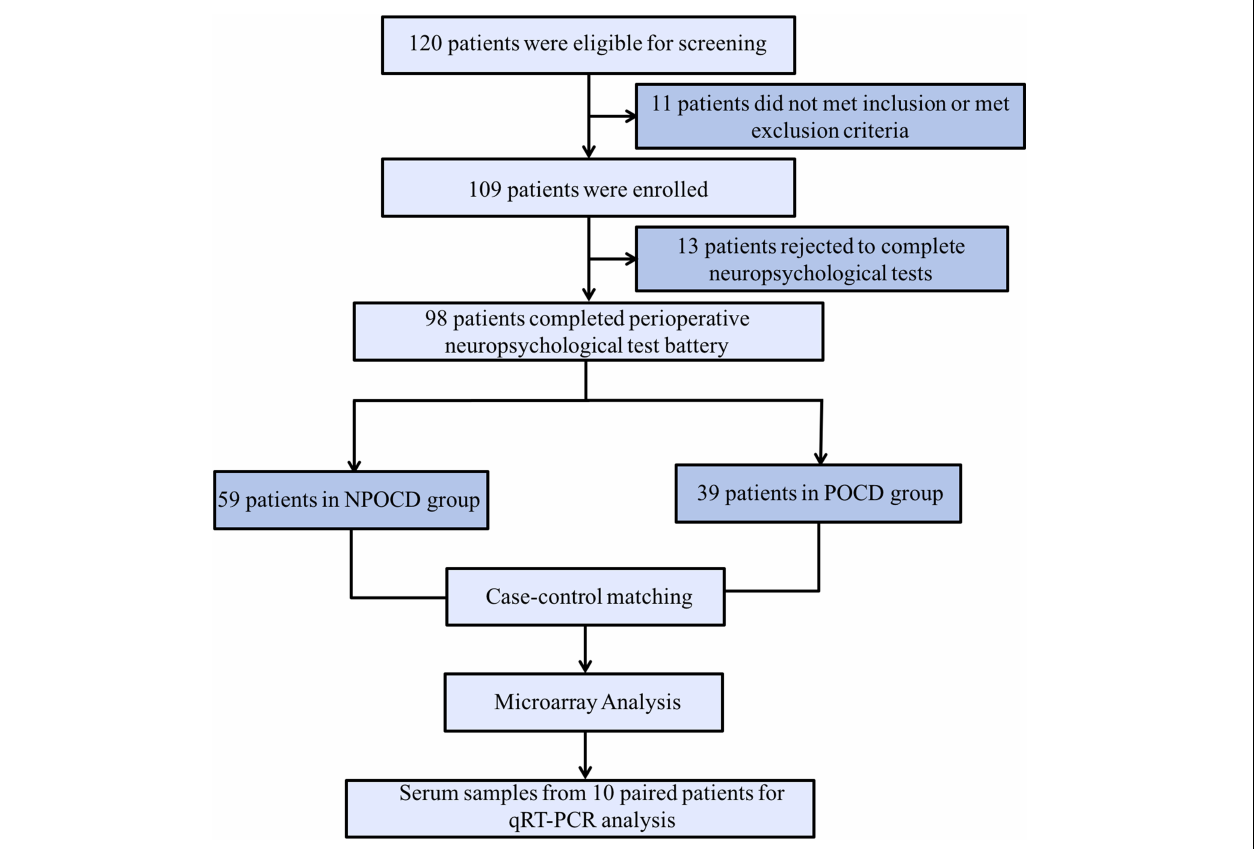
FIGURE 1 | The process flow diagram of the experiment. POCD, postoperative cognitive dysfunction; NPOCD, the patients without postoperative cognitive decline; qRT-PCR, quantitative real-time PCR.